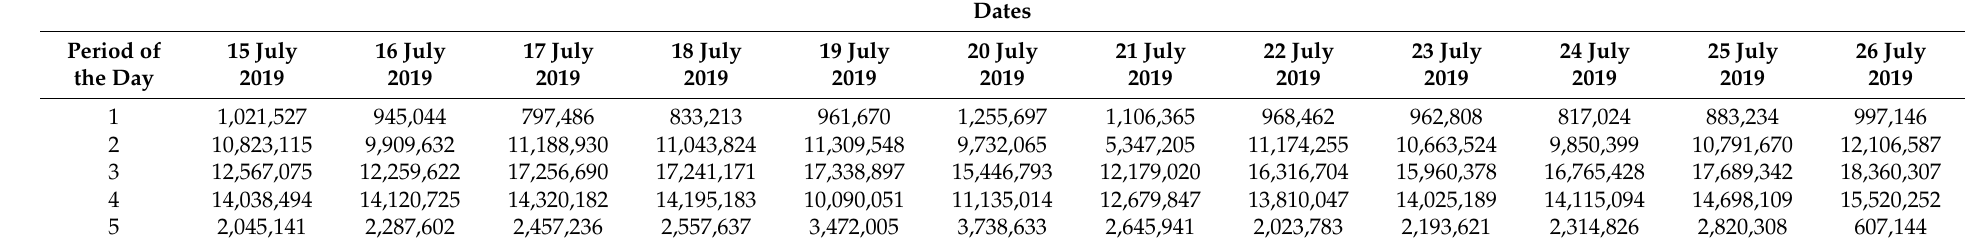
Table A6. Olifantsfnt SB